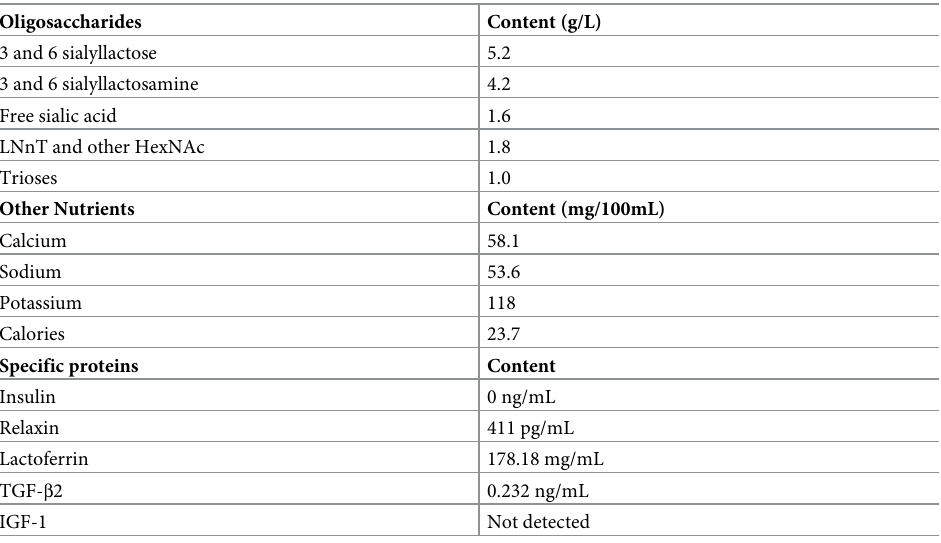
Table 2. Composition of liquid bovine colostrum